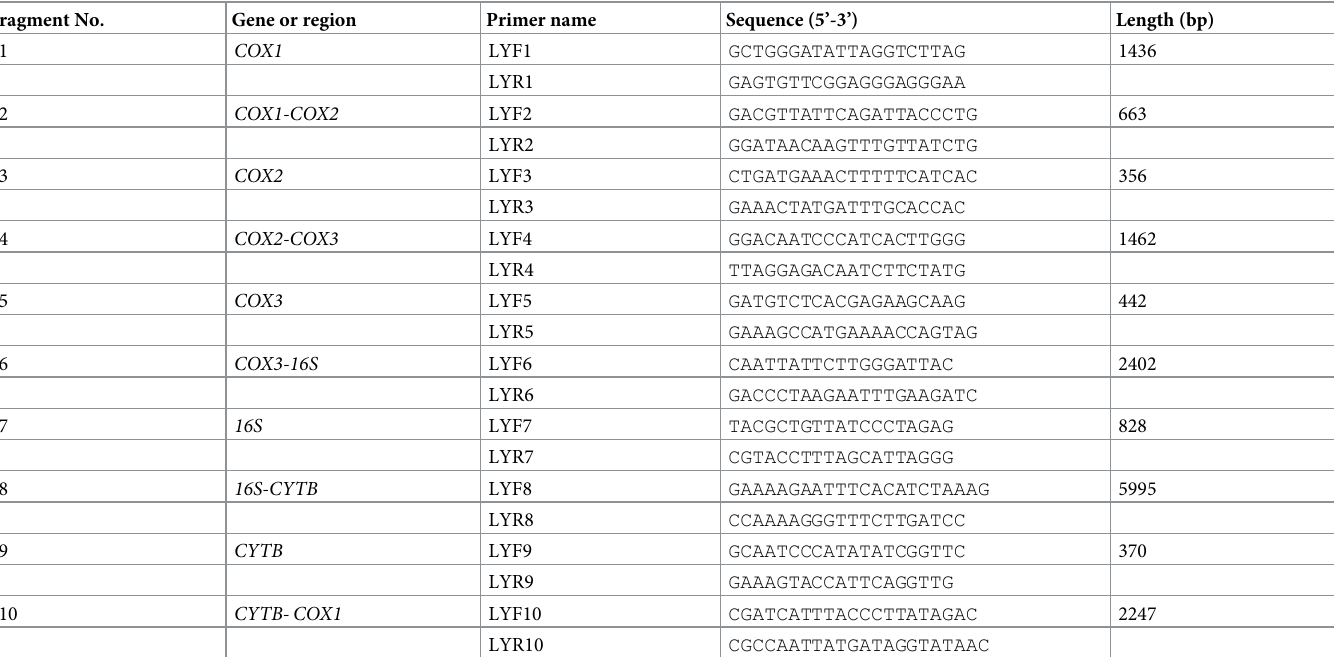
Table 2. Primers used for amplification and sequencing of the mitochondrial genomes of Hyalomma asiaticumasiaticum and kozlovi . Fragment